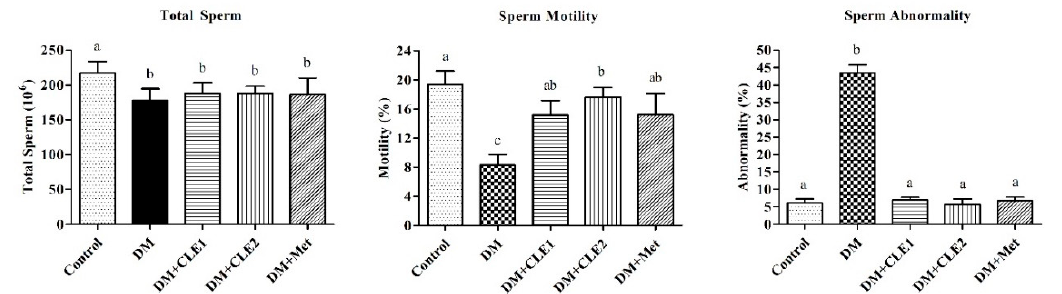
Figure 7 . The sperm parameters were analyzed by determining the total sperm count, motility, and abnormality of the diabetic mice after treatment for 6 weeks. Data are shown as mean ± SD ( n = 5). The values with different letters (a–b) represent significant difference ( p < 0.05) as analyzed by a Duncan’s multiple range test. DM, diabetes; DM+CLE1, diabetes and 600 mg/kg of C. lentillifera ; DM + CLE2, diabetes and 1000 mg / kg of C. lentillifera ; DM + Met, diabetes and 200 mg / kg of metformin.